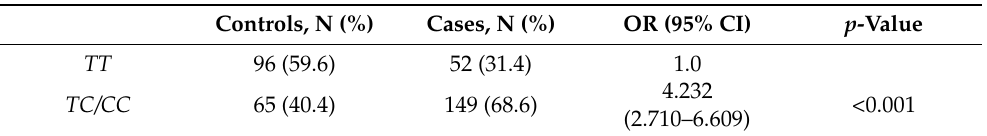
Table 8. Distribution of CYP19A1 codon 39 polymorphisms in cases (infertile women) and controls (fertile